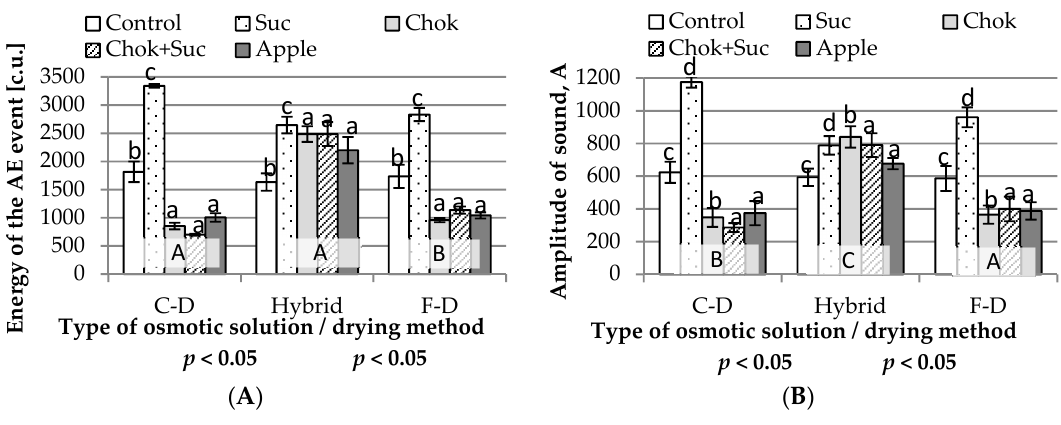
Figure 4. Influence of the type of osmotic solution and drying method on: ( A ) energy of the acoustic emission (AE) event and ( B ) amplitude of sounds of quince chips. Designations: a–d and A–C—homogeneous groups; Suc, Chok, Chok + Suc, Apple—coding the type of osmotic solution and C-D, Hybrid, F-D—coding the type of drying method as given in the experimental procedure.